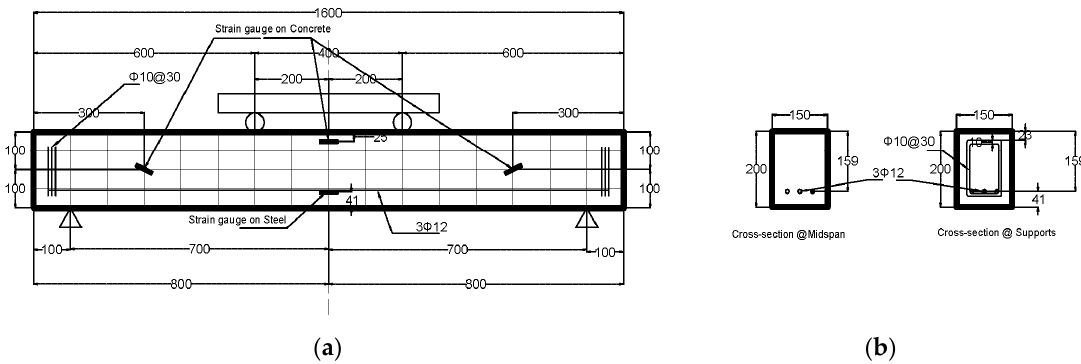
Figure 4. Samples preparation for mechanical properties. ( a ) Molds used for sample preparation, ( b ) Samples for mechanical evaluation.